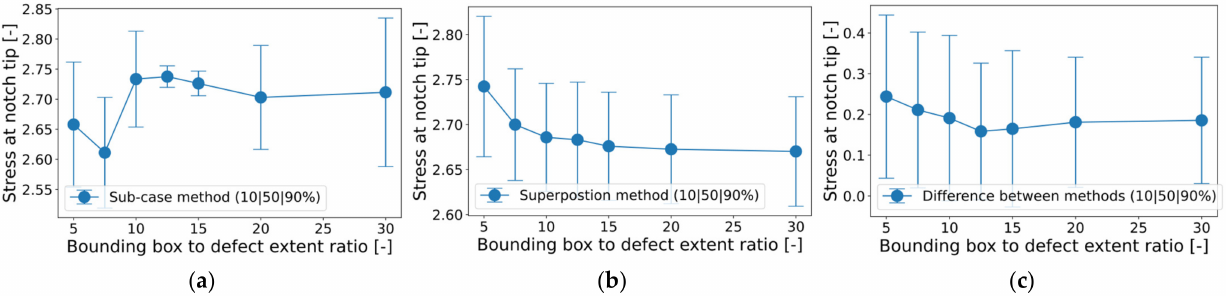
Figure 15. Assessment of maximum notch tip stress of circular hole-in-plate with increased bounding box (mesh list ‘circle_lin_R1mm_v1,v2 ...v7’) for incremental load step of ∆ ϕ = 10 ◦ : ( a )